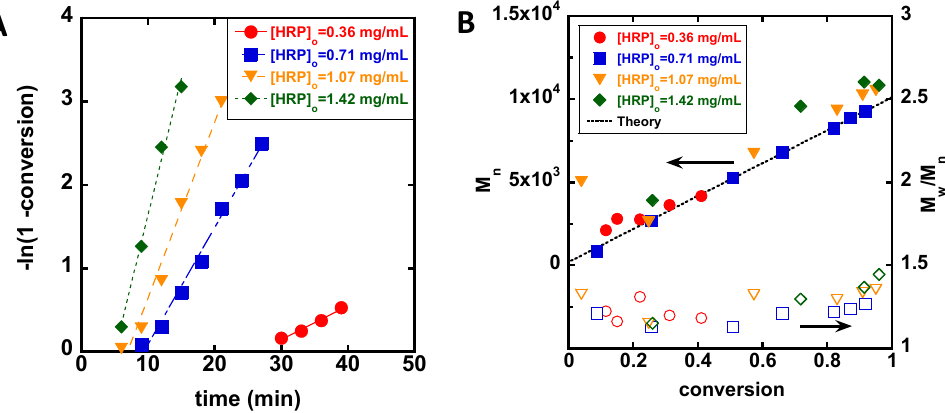
Figure 1. ( A ) Semilogarithmic plots and ( B ) evolution of M n (solid points) and M w / M n (open points) of HRP-catalyzed polymerization. Red points (circles) show [HRP] 0 = 0.36 mg/mL. Blue points (squares) show [HRP] 0 = 0.71 mg/mL. Orange points (triangles) show [HRP] 0 = 1.07 mg/mL. Green points (diamonds) show [HRP] 0 = 1.42 mg/mL. Assays were conducted with component ratios of [DMAm] 0 :[PAETC] 0 :[ACAC] 0 :[H 2 O 2 ] 0 = 100:1:9.7:1.7, and concentrations of [DMAm] = 170 mM, [HRP] = X mg/mL in 4.2 mL of pH = 5.5, 20 mM acetate buffer at 25 ◦